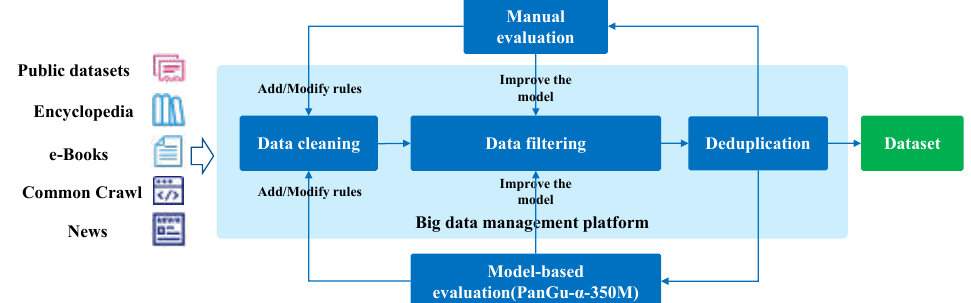
Figure 13 Construction process of PanGu-α dataset [41]. Figure 2: The data sources and the process of constructing pretraining data for PanGu- α